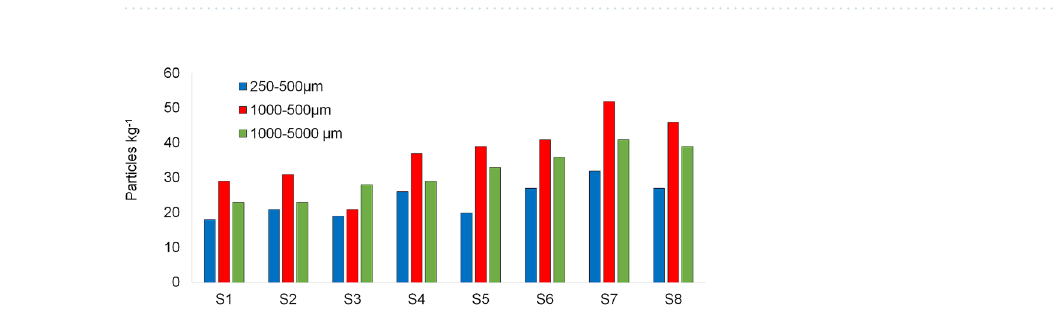
Figure 6. Microplastics abundance (particles kg −1 ) by color in sea salt samples from stations S1 to S8.